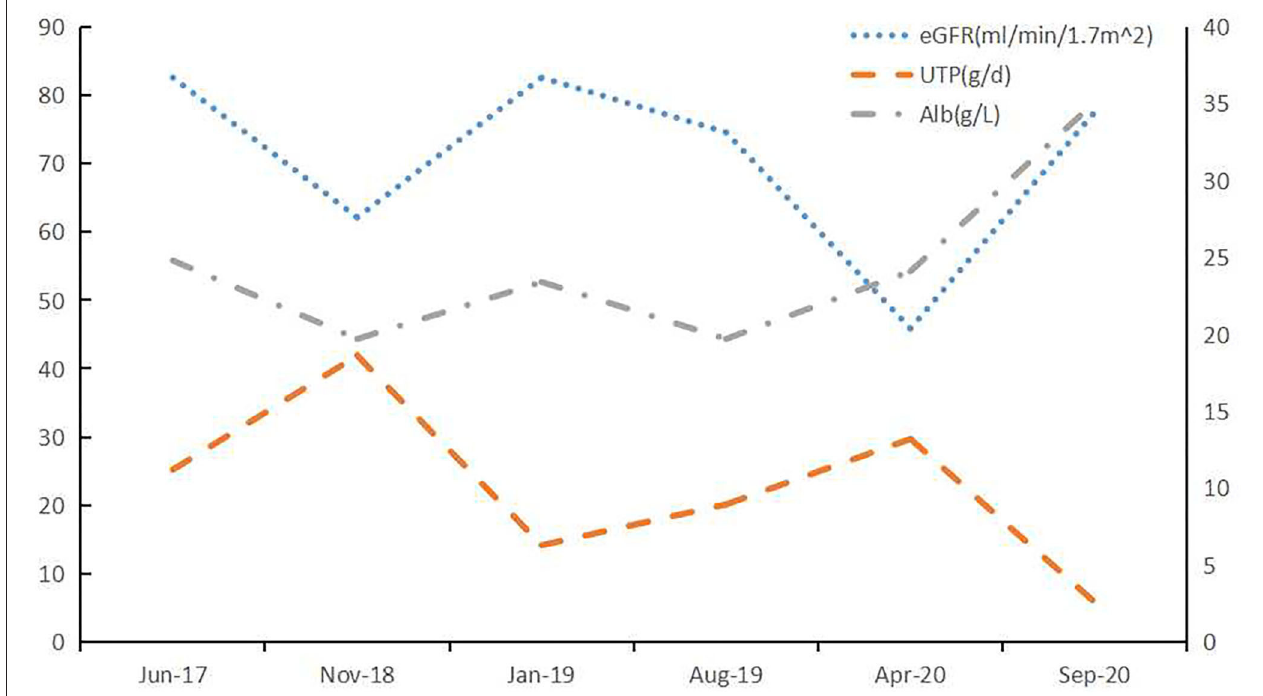
FIGURE 2 | Light, immunofluorescence, electron, and immunoelectron microscopy findings in Case 2. (A) Immunofluorescence staining revealed bright κ deposition in the mesangial area and along capillary walls ( × 400). (B) Light microscopy revealed a membranoproliferative pattern of injury (periodic acid-silver methenamine + Masson trichrome staining, × 400). (C) Electron microscopy demonstrated electron-dense deposits in subendothelial and mesangial regions ( × 8,000). (D) Immunoelectron microscopy showed κ deposition in the mesangial area and inner GBM ( × 8,000).